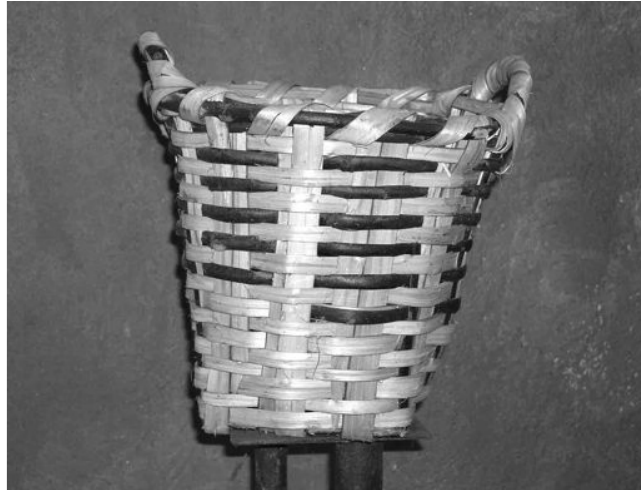
Fig. 8 - Traditional harvesting basket made with chestnut